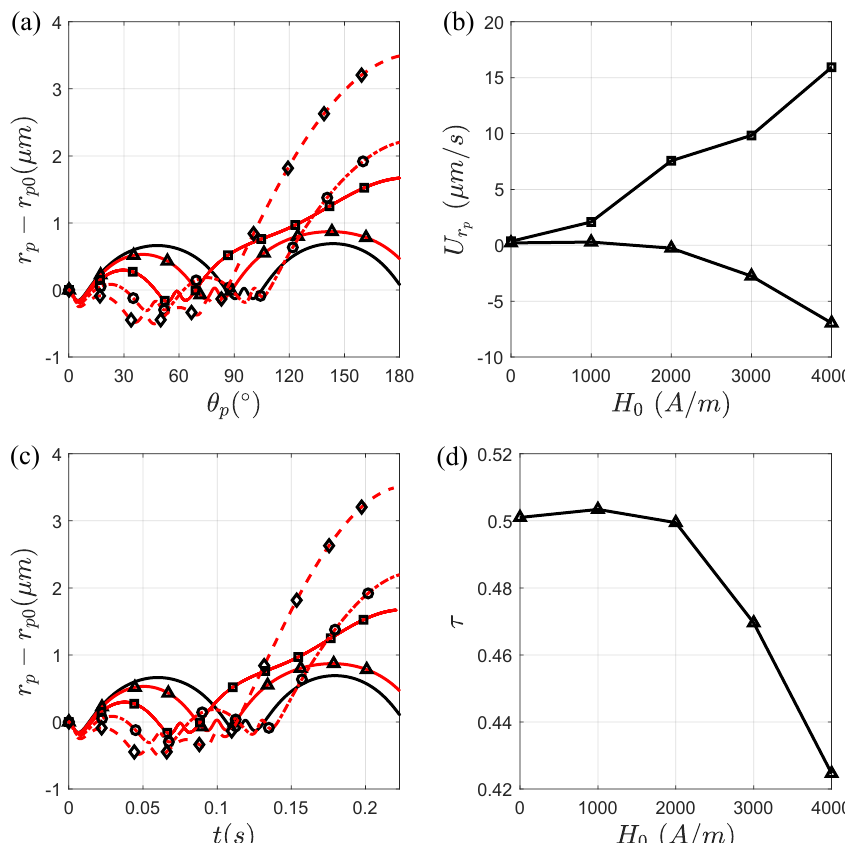
Figure A1. Effect of the magnetic field strength when it is applied at α = 0 ◦ on an elliptical particle ( AR = 4) that is in the upper curve of the channel. The particle is affected by the magnetic field when its center of mass is approximately at θ p = 0. The radial particle-wall distance change of the particle with respect to ( a ) θ p , and ( c ) time for, H 0 = 0 A/m (solid black line), H 0 = 1000 A/m (triangle symbol), H 0 = 2000 A/m (square symbol), H 0 = 3000 A/m (circular symbol), H 0 = 4000 A/m (diamond symbol). ( b ) The radial velocities U rp (triangle symbol) and U r θ (square symbol) are functions of H 0 . ( d ) The dimensionless parameter τ as a function of H 0 . We see that as τ decreases, the net migration of the particle